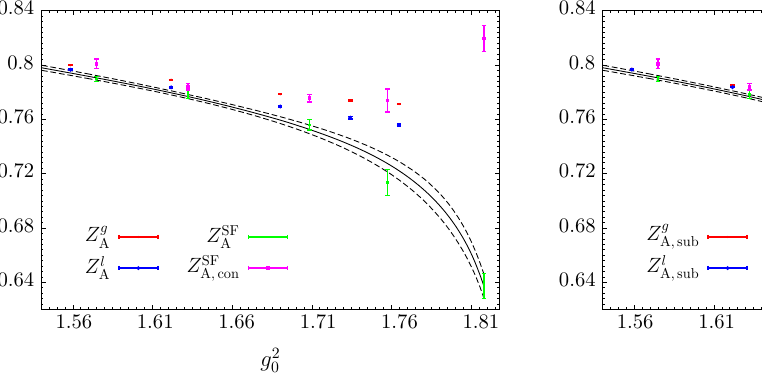
Fig. 6 Comparison between different Z A determinations for N f = 3, and correspond to the definitions Z A , 0 and Z con obtained either from WIs in the standard SF or from universality rela- reference.Thesolidblacklineisthefitformulato Z SF tionsinthe χ SF.The χ SF resultsaretakenfromTable7andtheeffectof and the dashed lines delimit the 1 σ region of the fit. Note that this fit the perturbative one-loop improvement is shown in the right panel. The function enforces the perturbative 1-loop behaviour for g 2 individual SF points labelled Z SF and Z SF are taken from Ref. [22] A A , con